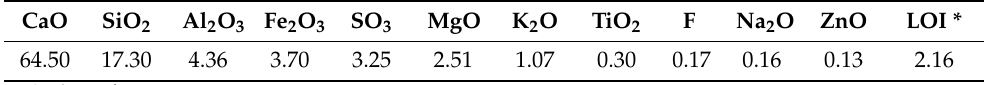
Table 1. Oxide composition (%) of the cement obtained by XRF